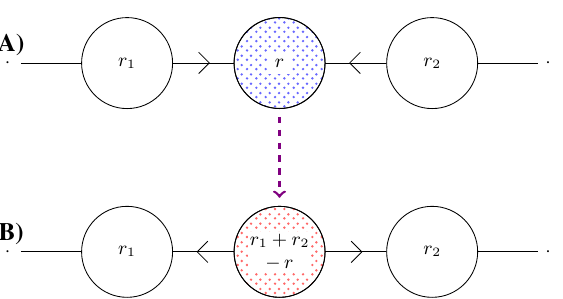
Fig. 7 2d Seiberg duality on a node with only anti-chiral fundamental matter realized by adjacent 2d gauge nodes. There are no mesonic fields introduced in this case